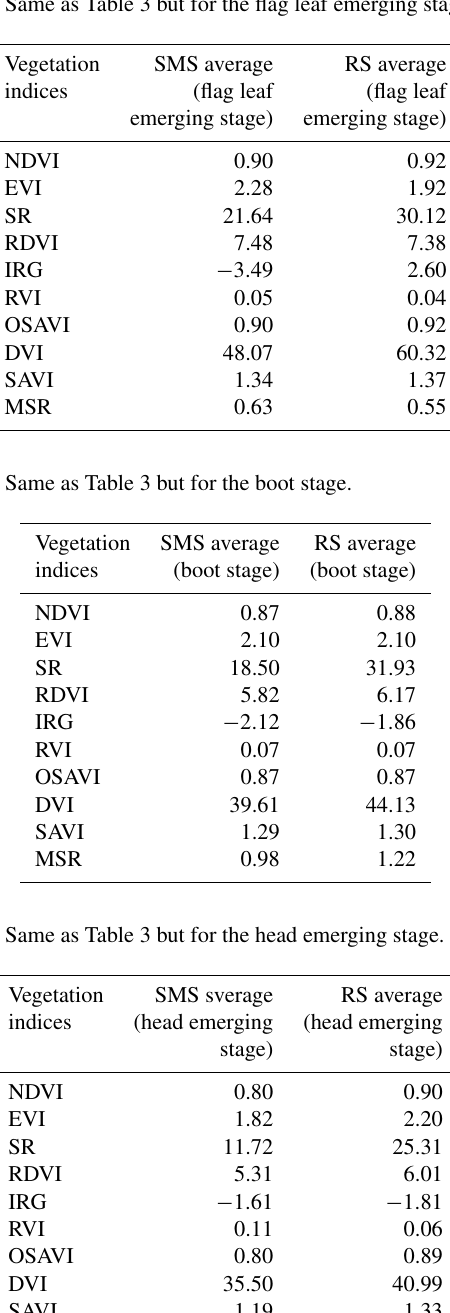
Table 4. Same as Table 3 but for the flag leaf emerging stage.